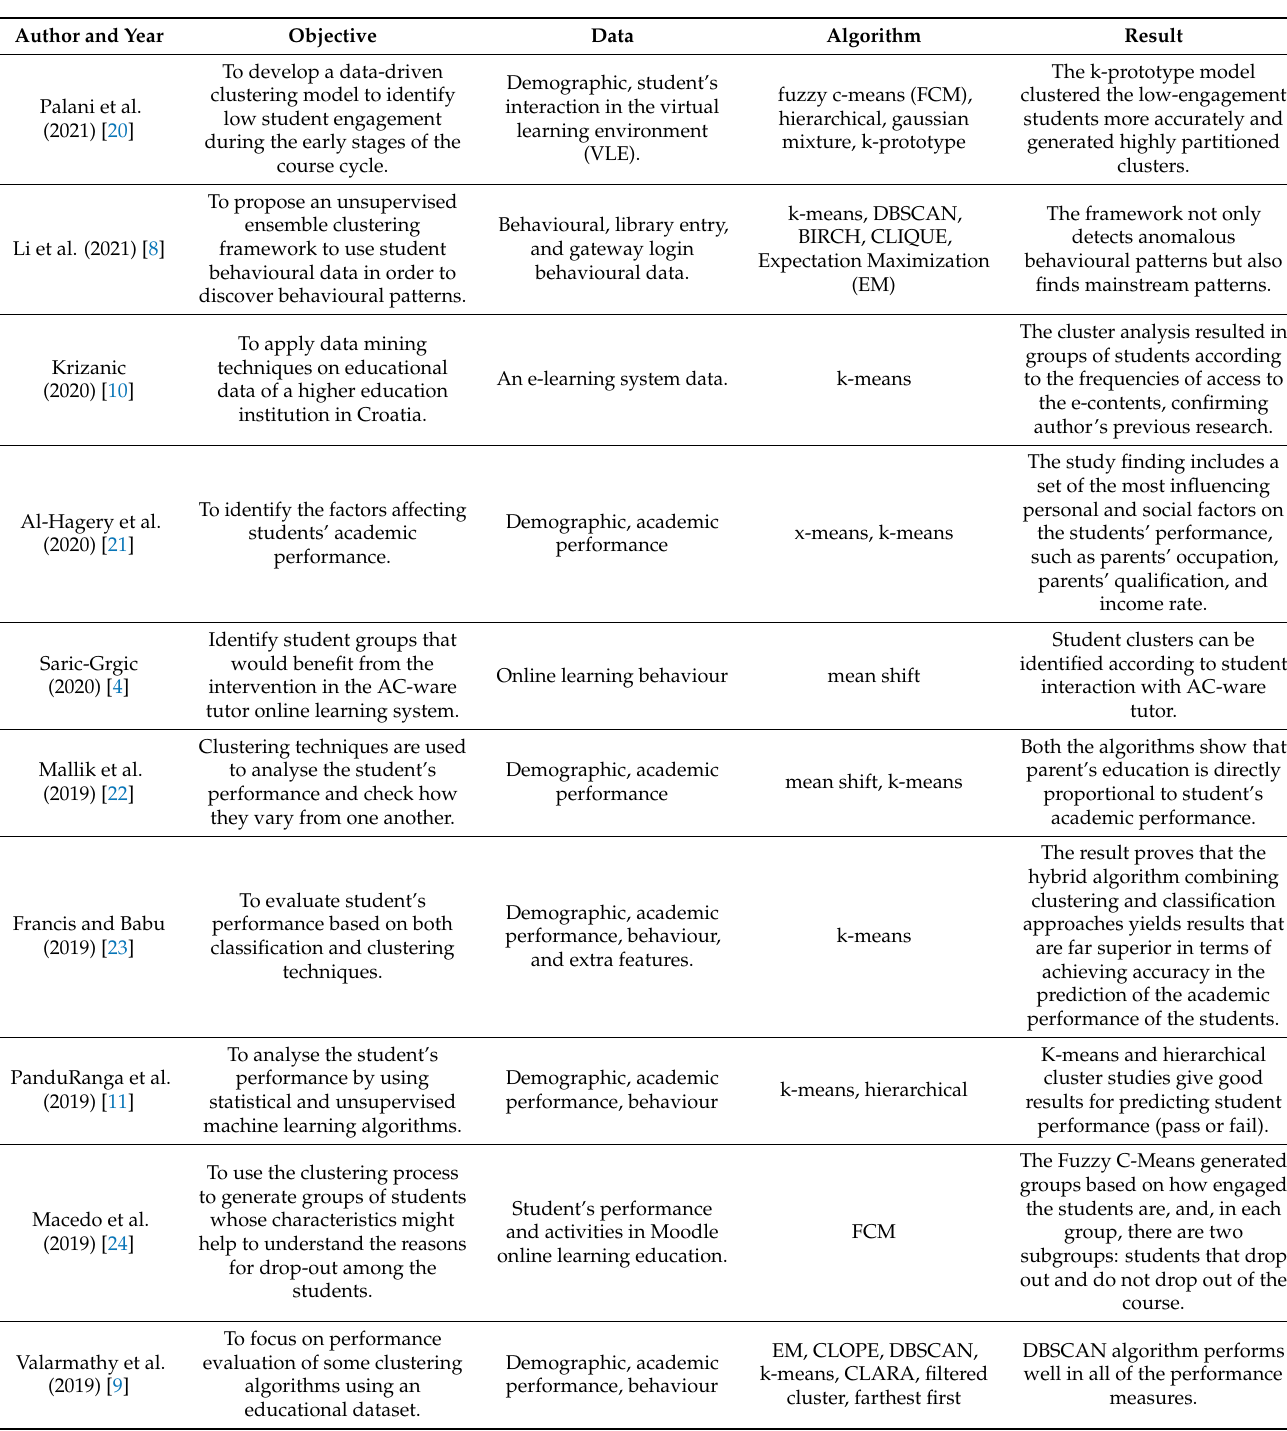
Table 1. List of studies and types of machine learning algorithms in the education